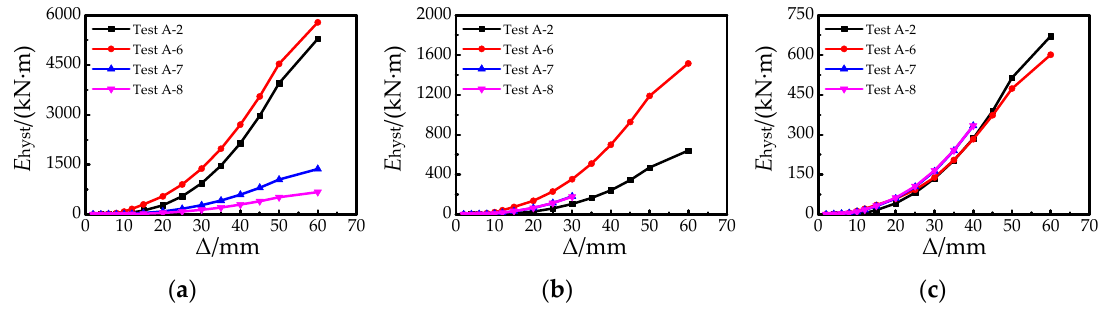
Figure 9. Accumulative energy dissipation curves: ( a ) Pier top; ( b ) Node8; ( c ) Node18.